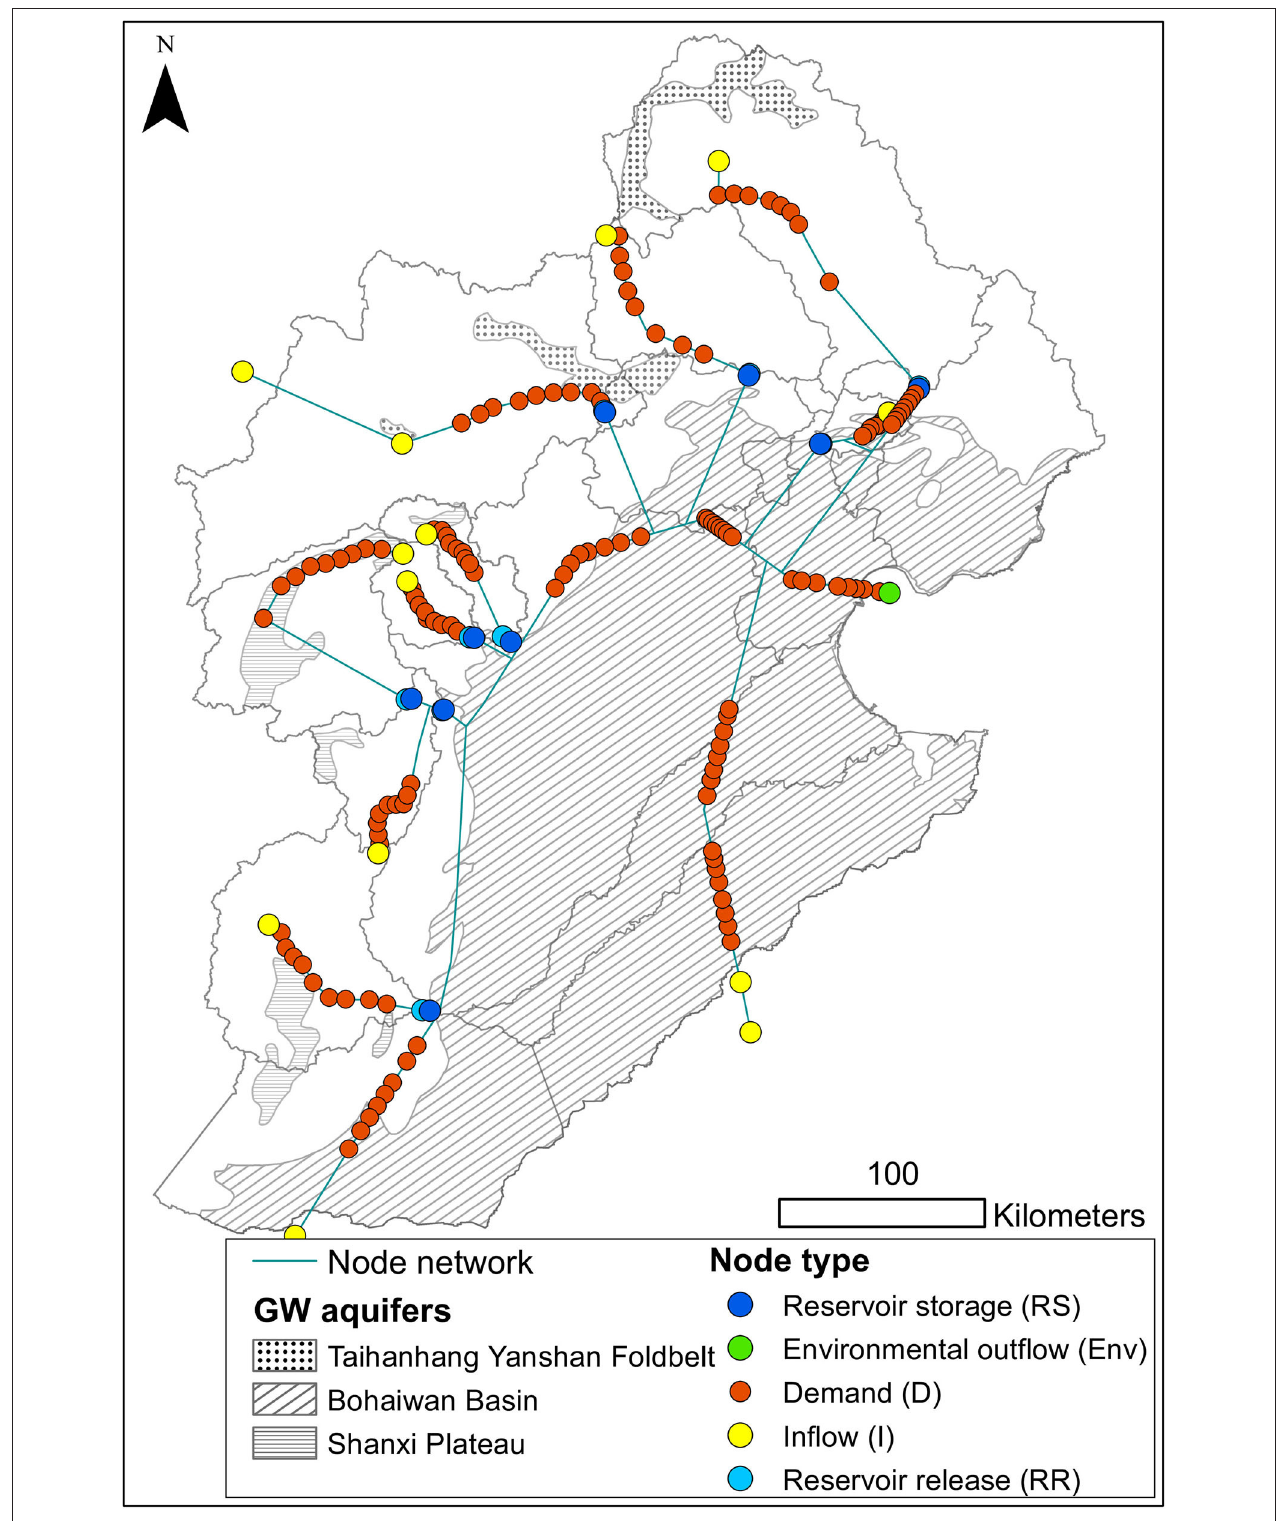
FIGURE 2 | Conceptual illustration of the 16 sub-basins of the optimization model, the major groundwater recharge areas and the network of water sources (RR, I) and sinks (RS, Env, D) used to formulate the model flow path decision variables.